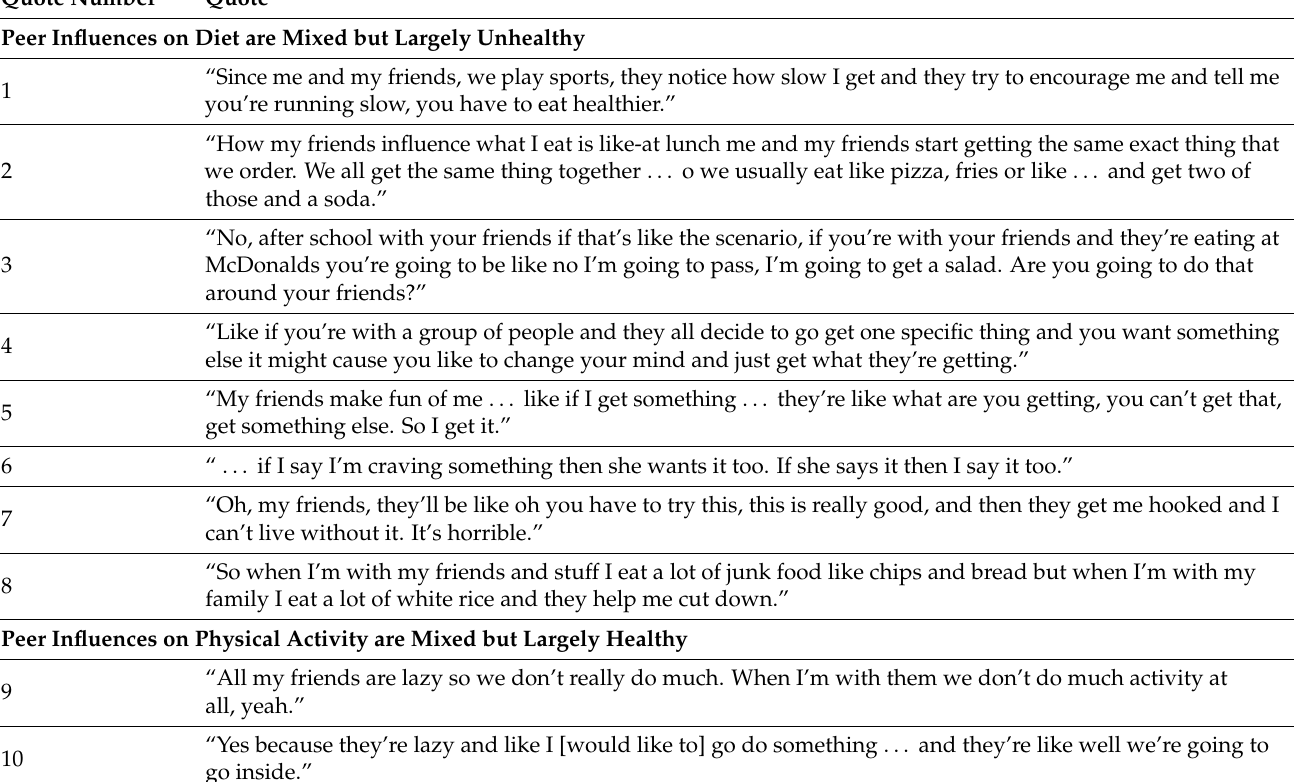
Table 1. Representative Subthemes and Supporting Quotes for Theme 1: Adolescents generally encounter unhealthy peer influences related to dietary choices and healthy peer influences related to physical